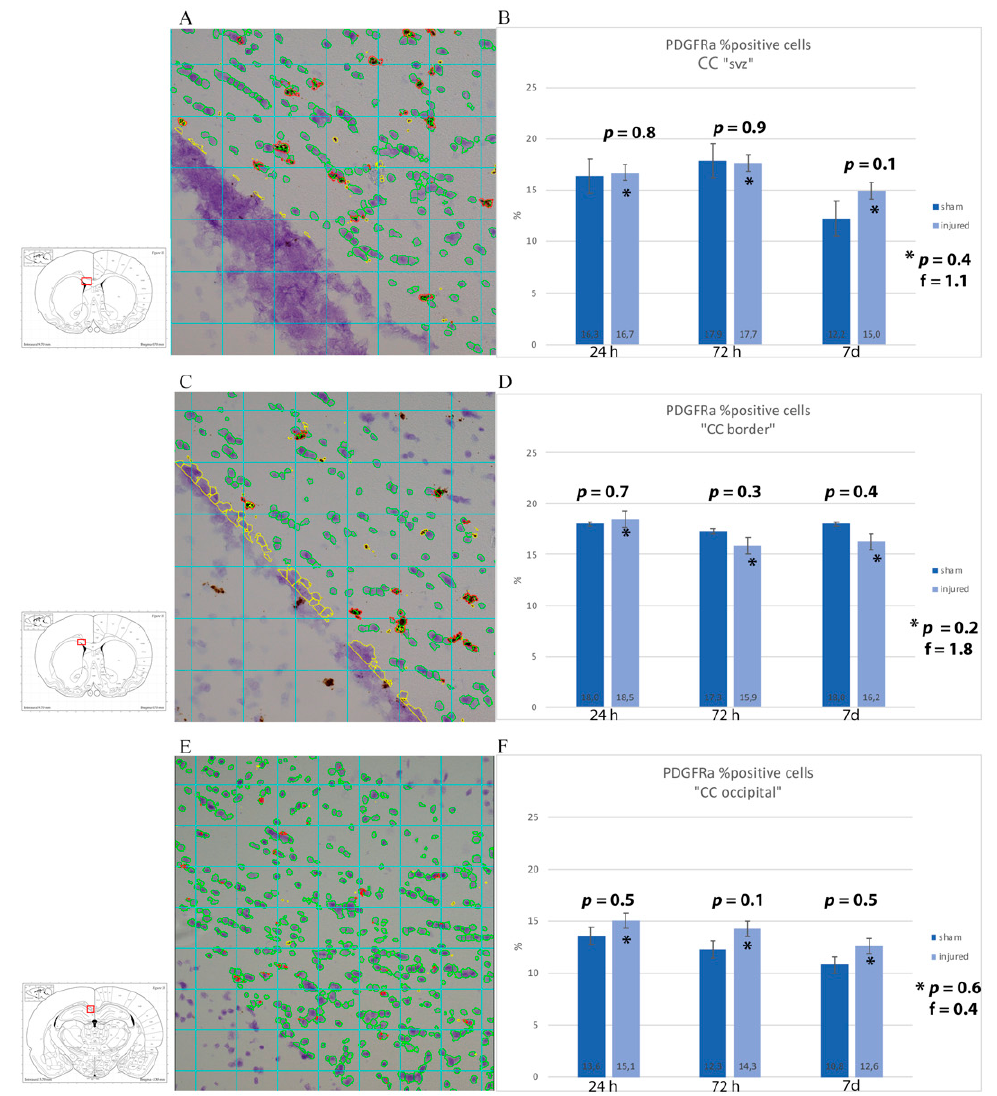
Figure 9. RNAscope analysis with PDGFRa mRNA probe of corpus callosum. ( A , C , E ) Sample of RNAscope light microscopy picture of injured subjects set for analysis with Fiji ImageJ. The insert shows the region of interest squared in red, namely ( A ) CC just dorsal of the subventricular zone (CC “SVZ”), ( C ) area of the corpus callosum at around 1 mm from Bregma at the border with the caudoputamen, and ( E ) corpus callosum at around − 3 mm from Bregma. All the cells considered for the analysis are circled in green, while in red are the PDGFRa probe clusters. In yellow is what has been manually excluded because it was considered as background / not part of the region of interest. ( B , D , F ) Results from the image analysis are presented as averages of the percentages of the number of cells expressing PDGFRa mRNA out of the total number of cells from each subject in the ROI. While a trend of an increased number of PDGFRa-expressing cells was observed in injured as compared to sham when analyzing the whole width of the corpus callosum at around 1 and − 3 mm from bregma, this is not true when considering a smaller ROI of the corpus callosum at around 1 mm from bregma. Moreover, such di ff erences were at no timepoint statistically significant. * p indicates results from one-way ANOVA analysis, while p is from Student t